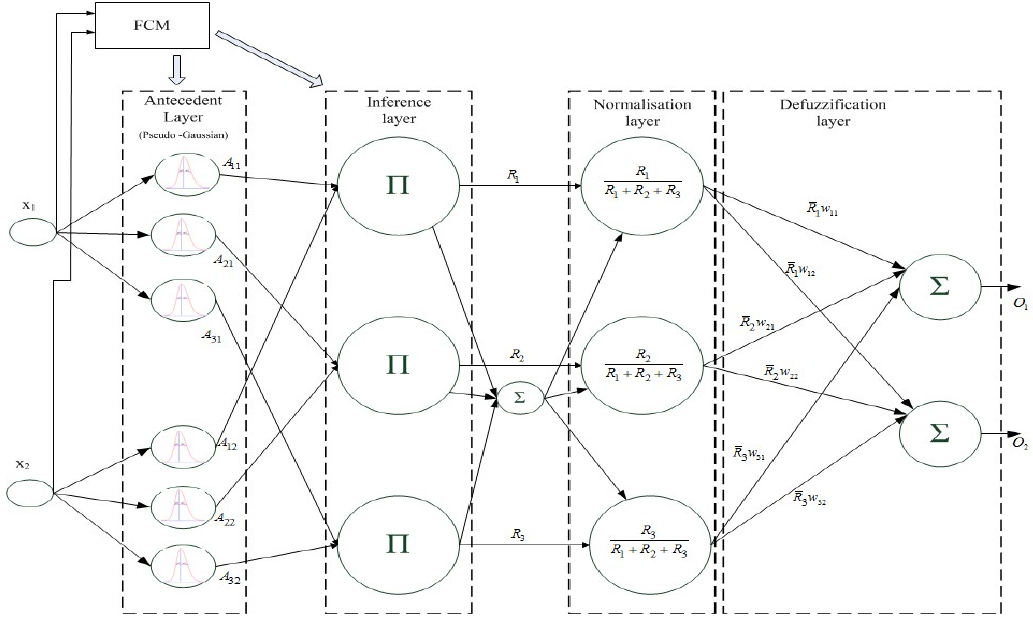
Figure 1. Illustration of AGFINN-CA system.